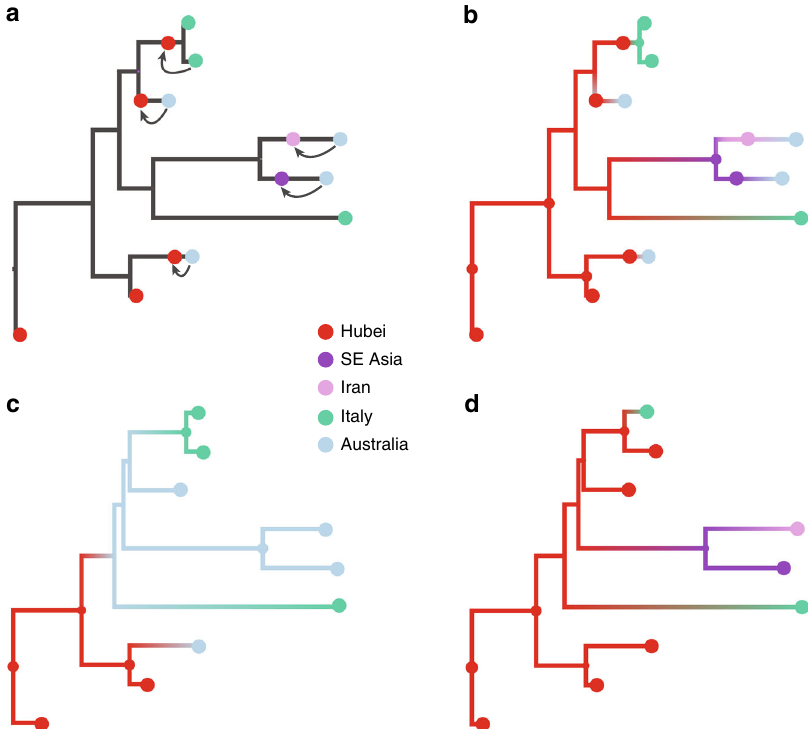
Fig. 7 Incorporating travel history data in phylogeographic reconstruction. a The concept of introducing ancestral nodes associated with locations from which travelers returned. The ancestral nodes are indicated by arrows for fi ve cases relating them to the genomes sampled from the travelers. The ancestral nodes are introduced at different times in the ancestral path of each sampled genome. b – d The results from analyses using sampling location and travel history, sampling location only, and travel origin location, respectively. The branch color re fl ects the modal state estimate at the child node. There is some topological variability, but only involving nodes that are poorly